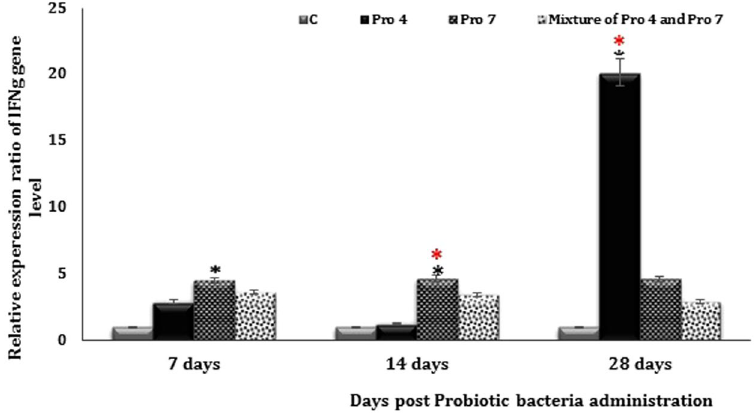
Figure 6. Regulation of IFN γ gene expression in all mice groups following treating with probiotic bacteria. Where C represented untreated group Pro 4 represent group treated with Lactobacillus paracasei/casei , Pro 7 represent group treated with Lactobacillus rhamnosus and a mixture of Pro 4 and Pro 7 represent group treated with a mixture of 1:1 from Lactobacillus paracasei/casei and Lactobacillus rhamnosus . Total mRNA was isolated from the intestine of the indicated mouse strains and subjected to IFN γ real-time PCR. ( * ) Significant at p < 0.05 as determined by analysis of variance, comparison was performed using One factor ANOVA test. ( * ) Comparison between controls and tested group. ( * ) Comparison between the treated groups. Every point represents the mean value of three separate tests and the vertical bars denote the 5% percentage around the